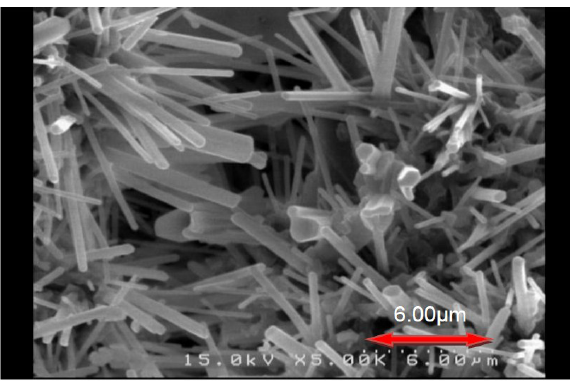
Figure 4. A typical SEM photograph of the product (Ca:Al:Si:NaN 3 :NH 4 Cl:Si 3 N 4 :Eu 2 O 3 = 0.92:1:0.25:3.5:0.6:0.25:0.04) after grinding and removing NaCl and the residual